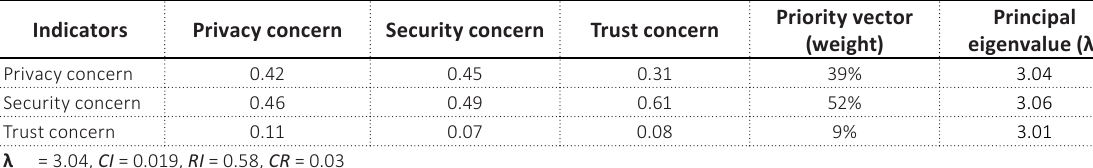
Table 8. Normalized weighted scores of various aspects of privacy Privacy concern